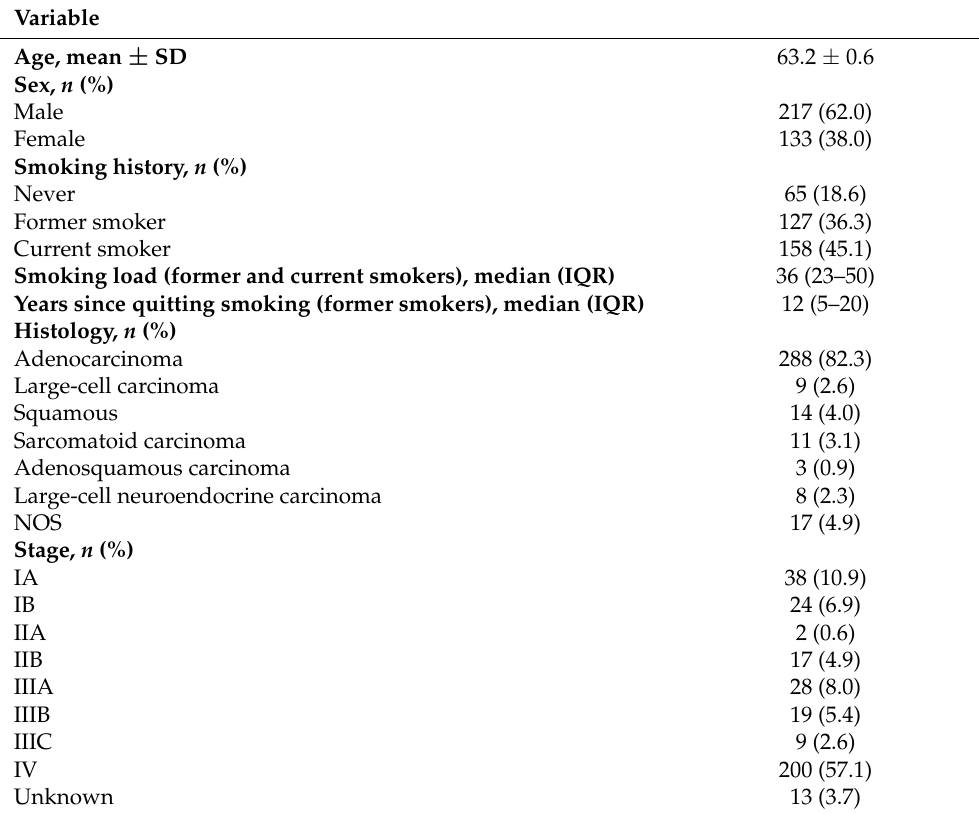
Table 1. Epidemiological and clinical–pathological characteristics of the recruited